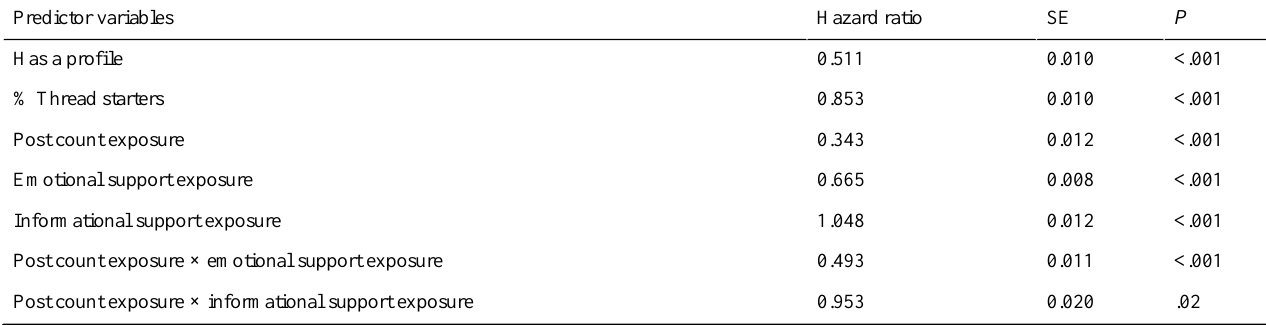
Table 7. Results of the survival